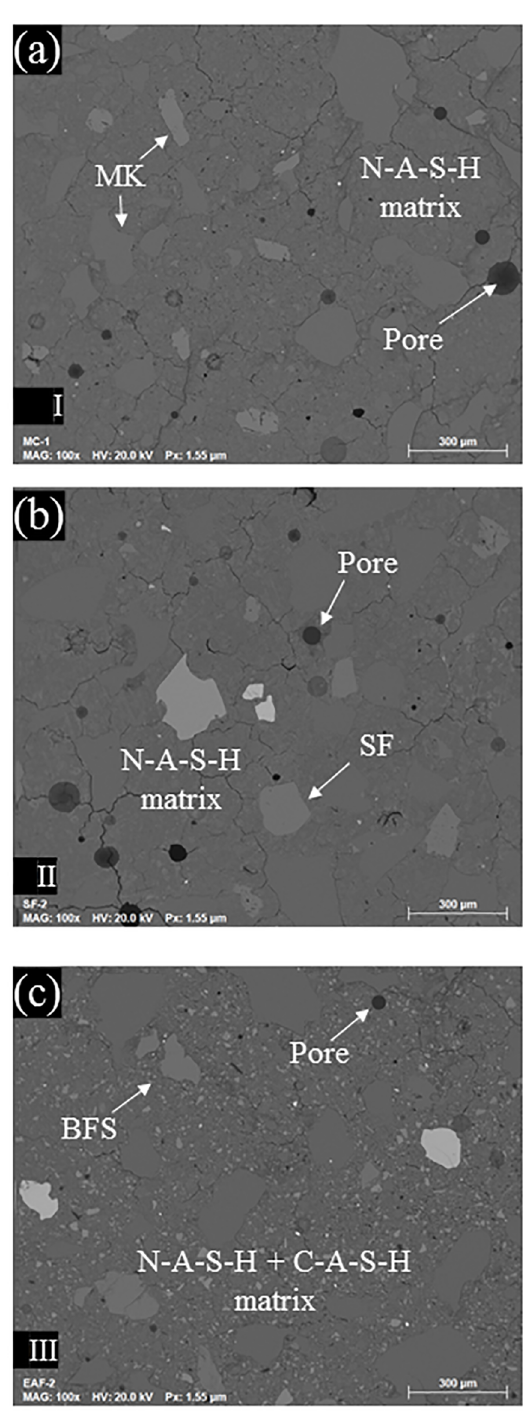
Figure 8. SEM micrographs showing the microstructure of polished samples of: (a) 100MK, (b) 80MK20SF and (c) 60MK40BFS. geopolymer mortars exhibited high compressive strength, reaching values as high as 82 MPa at 7